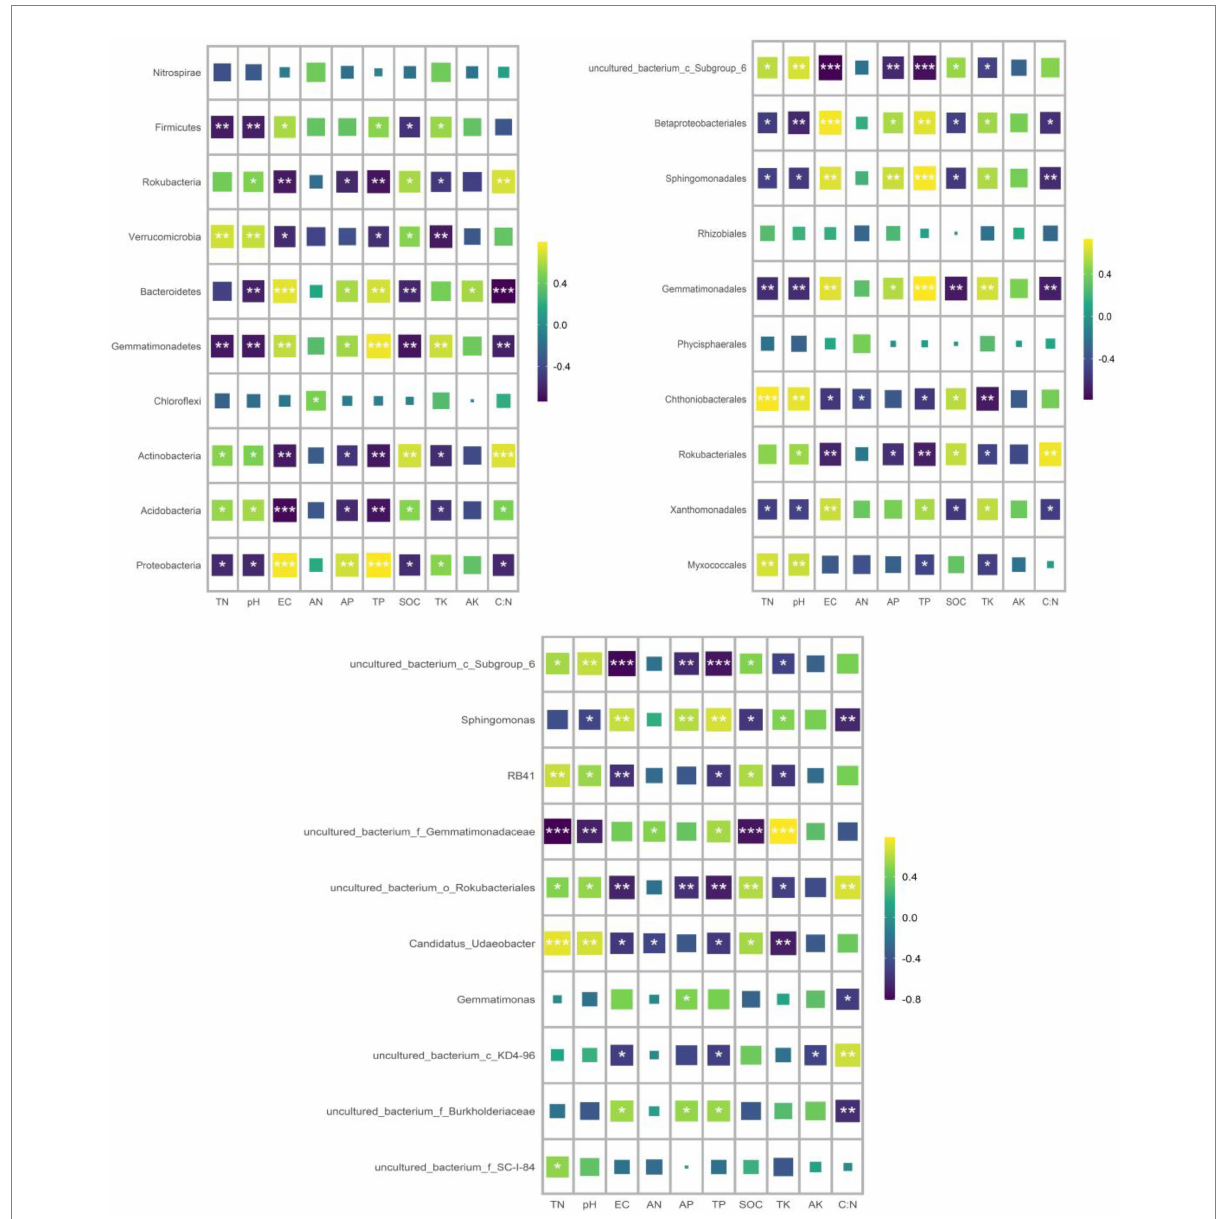
FIGURE 7 Spearman correlation analysis was conducted to analyze the correlation between the relative abundance of dominant bacterial groups and soil